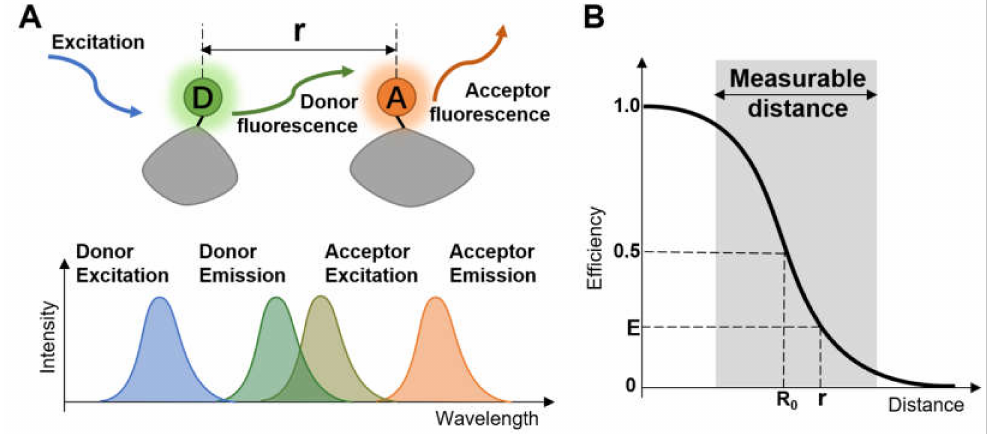
Figure 1. ( A ) Diagrammatic sketch of the concept of Förster resonance energy transfer; ( B ) Correlation between FRET efficiency and the